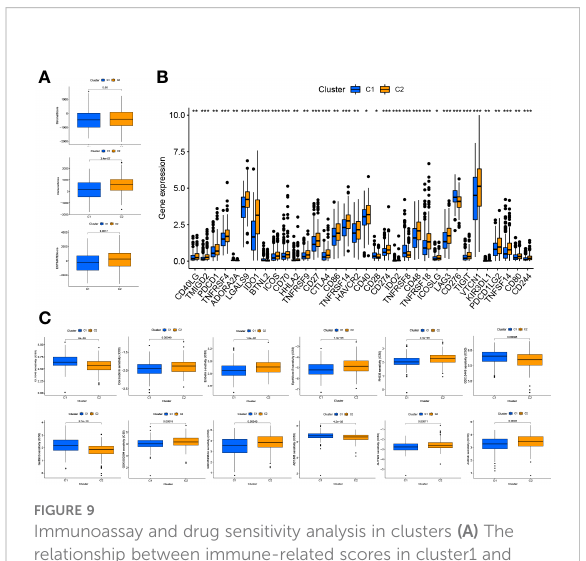
FIGURE 9 Immunoassay and drug sensitivity analysis in clusters (A) The relationship between immune-related scores in cluster1 and cluster2. (B) Immune checkpoints expression in risk groups. (C) Drug sensitive analysis in clusters. *: p < 0.05. **: p < 0.01. ***: p <